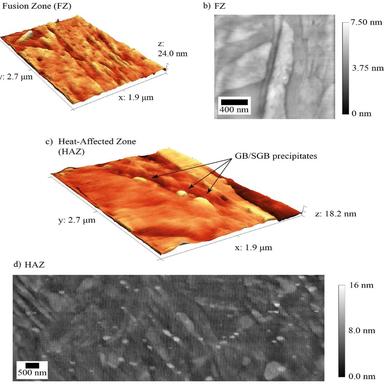
Selected large area HS-AFM images of the FZ (a, b) and the HAZ (c, d) with some large precipitates highlighted.